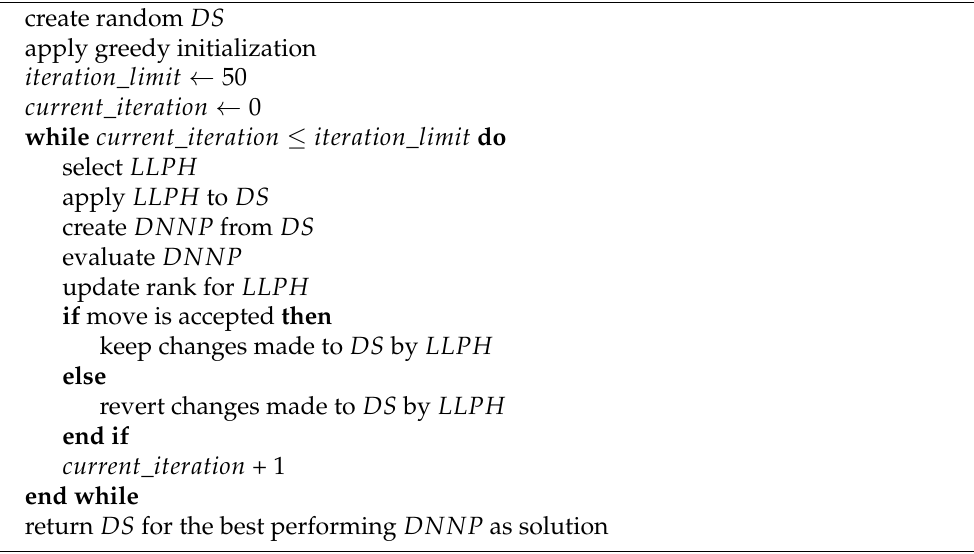
Algorithm 1 Single point selection-perturbative